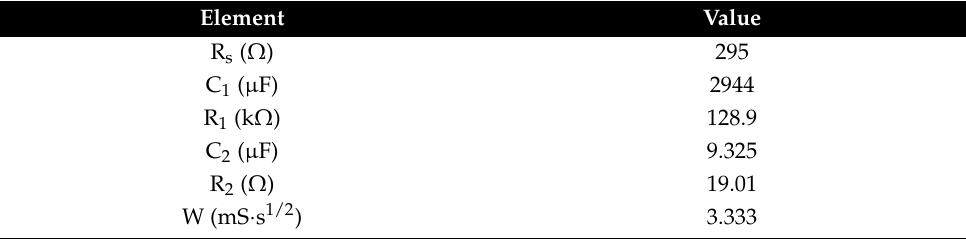
Figure 12. Electrochemical Impedance Spectroscopy (EIS) study (Nyquist plot) of 4 cm long Ni 10 /NCO/RGO twisted wire-shaped supercapacitor (WSC) at 100 kHz–0.01 Hz under 0.01 V (Inset shows the electrochemical equivalent circuit). Table 1. EIS fit results of 4 cm long Ni 10 /NCO/RGO twisted